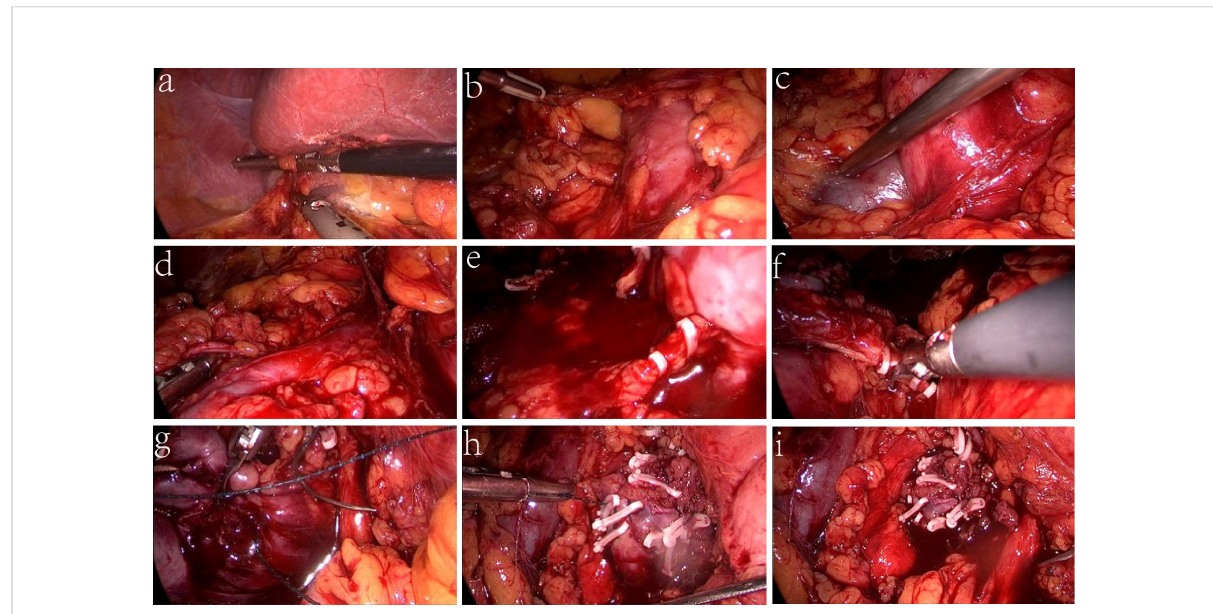
FIGURE 2 Key steps of the surgery. (A) Retracted the liver cephalad and exposed kidney. (B) Dissociated the ascending colon and duodenum to the midline. (C) Exposed the inferior vena cava. (D) Cut off the fi rst renal artery and vein. (E) Divided the vasa vasorum. (F) Cut off the second renal artery and vein. (G) Fully exposed the isthmus and started slicing. (H) Sutured the left renal isthmus stump. (I) Sutured the bladder and lateral